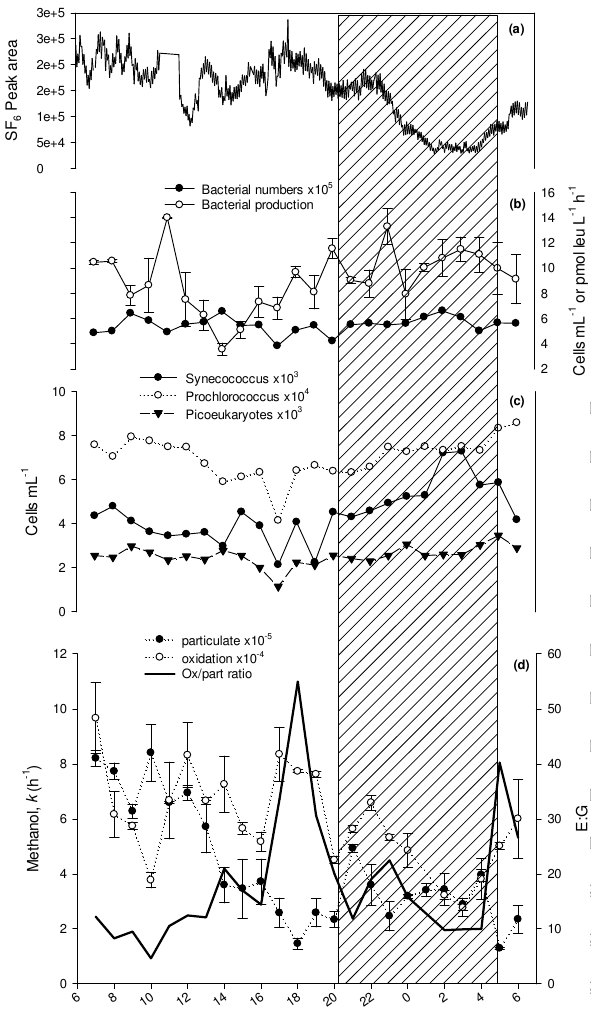
(cid:2) Fig. 5. Diel variability in (a) concentration of inert tracer SF 6 , (b) bacterial leucine incorporation and numbers of bacteria, (c) num- Figure 5 (cid:3)(cid:5)(cid:2) bers of Synechococcus, Prochlorococcus and Picoeukaryotes and (d) apparent rate constant ( k ) of methanol oxidation and uptake into cellular material with the microbial E:G, where the hashed area indi- cates hours of darkness. Error bars are based on at least 3